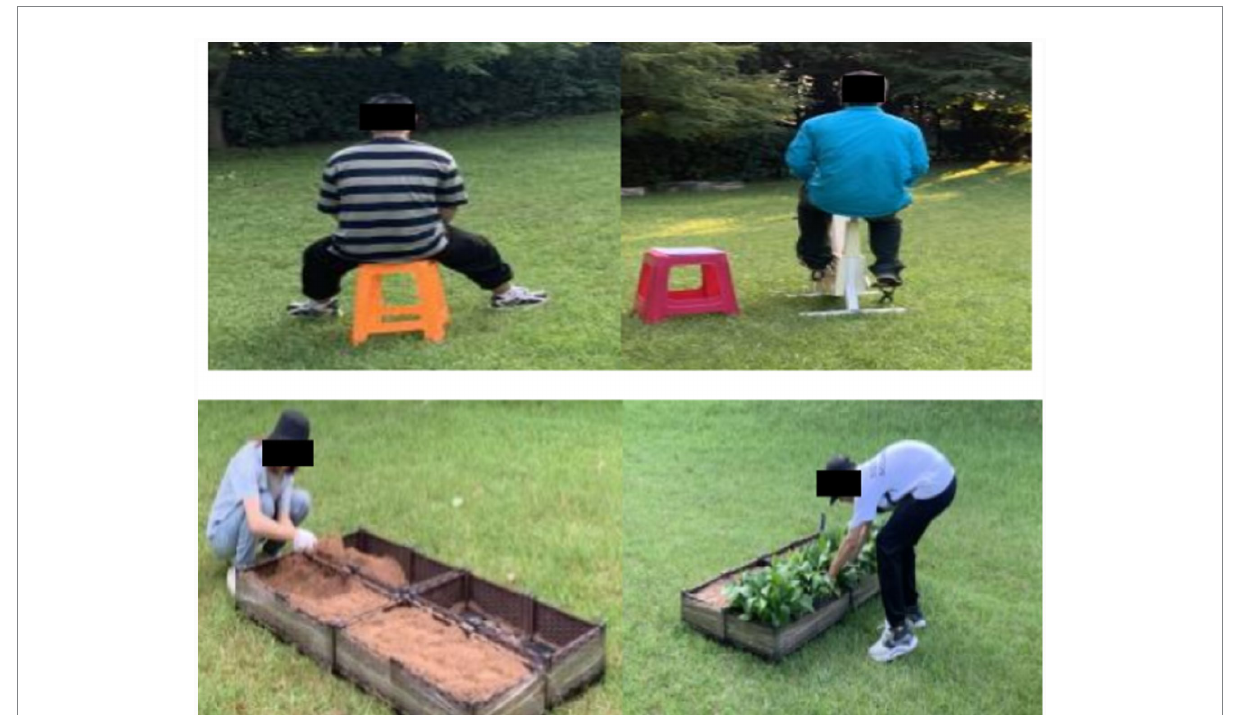
FIGURE 4 The scene photos of the sitting control group, the green exercise group, and the horticultural activity